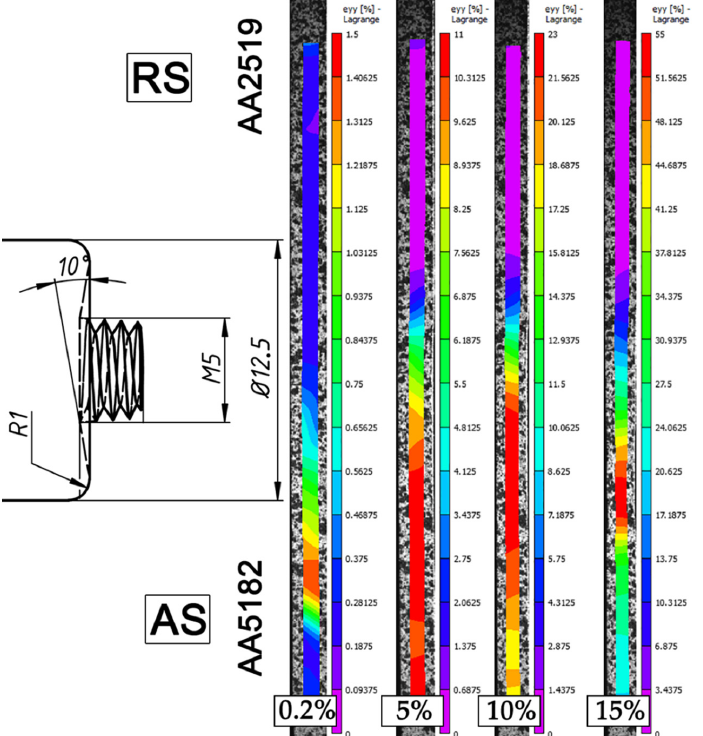
Figure 7. Distribution of local longitudinal strains on the cross-section side of the 1100@30 joint, which evolved during transverse tensile tests after total elongation of 0.2%, 5%, 10%, and immediately before failure. For clarity, a tool drawing is added. The tensile direction is vertical.